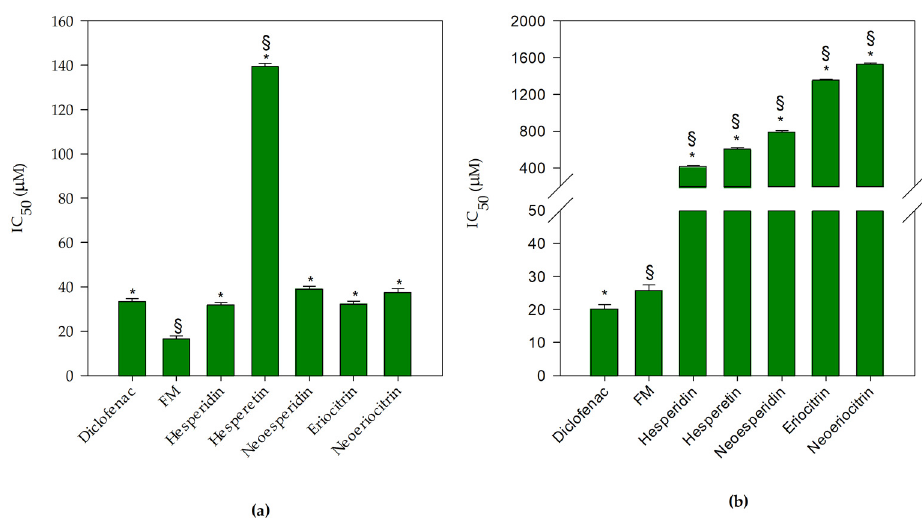
Figure 3. Anti-inflammatory activity of Citrus flavanones and flavanones mix (FM) in comparison with the reference anti-inflammatory drug diclofenac sodium: ( a ) protease inhibition assay ( b ) bovine serum albumin (BSA) denaturation assay. Results were expressed as mean half-maximal inhibitory concentration (IC 50 , µ M) ± S.D. of three independent experiments in triplicate ( n = 3); * p < 0.001 vs. FM; § p < 0.001 vs. diclofenac sodium.